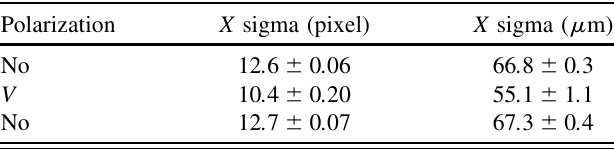
TABLE II. Summary of vertical-stripe data. The vertical ( V ) polarization data are indicated in determining the x sizes with the statistical uncertainty. The calibration factor was 5 : 3 (cid:1) m per pixel.